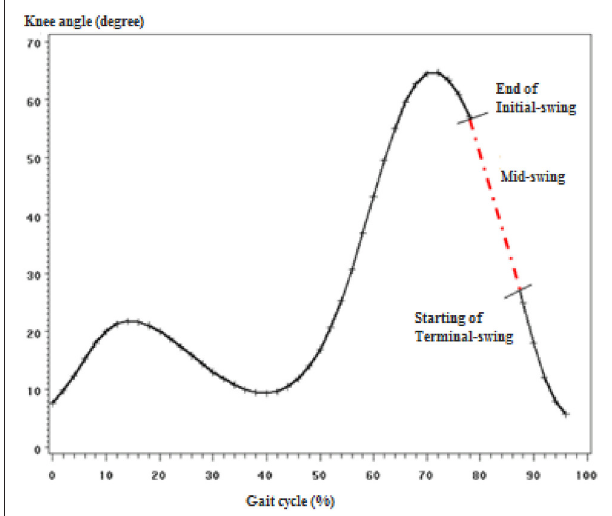
FIGURE 5 | Illustration of how the mid-swing phase connects the end of initial-swing with the start of terminal swing (knee angle curve).